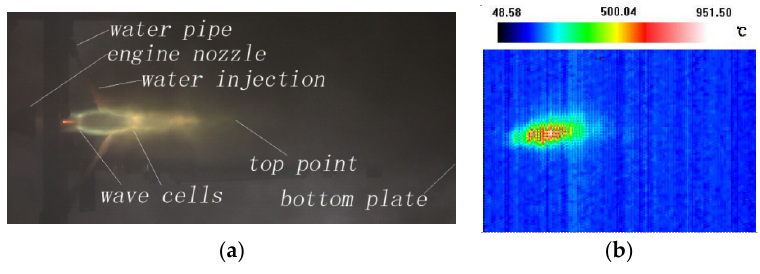
Figure 10. ( a ) High ‐ speed photograph; ( b ) IR image.